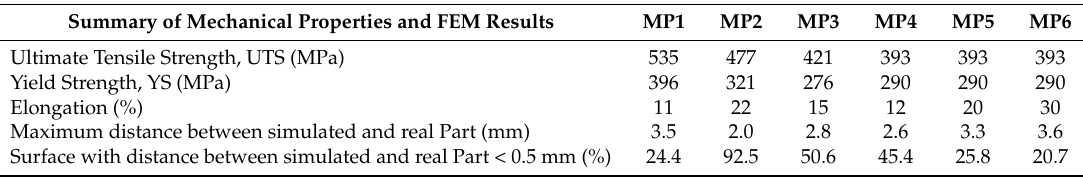
Table 4. Summary of Material Properties (MPs) and results of forming simulations with different